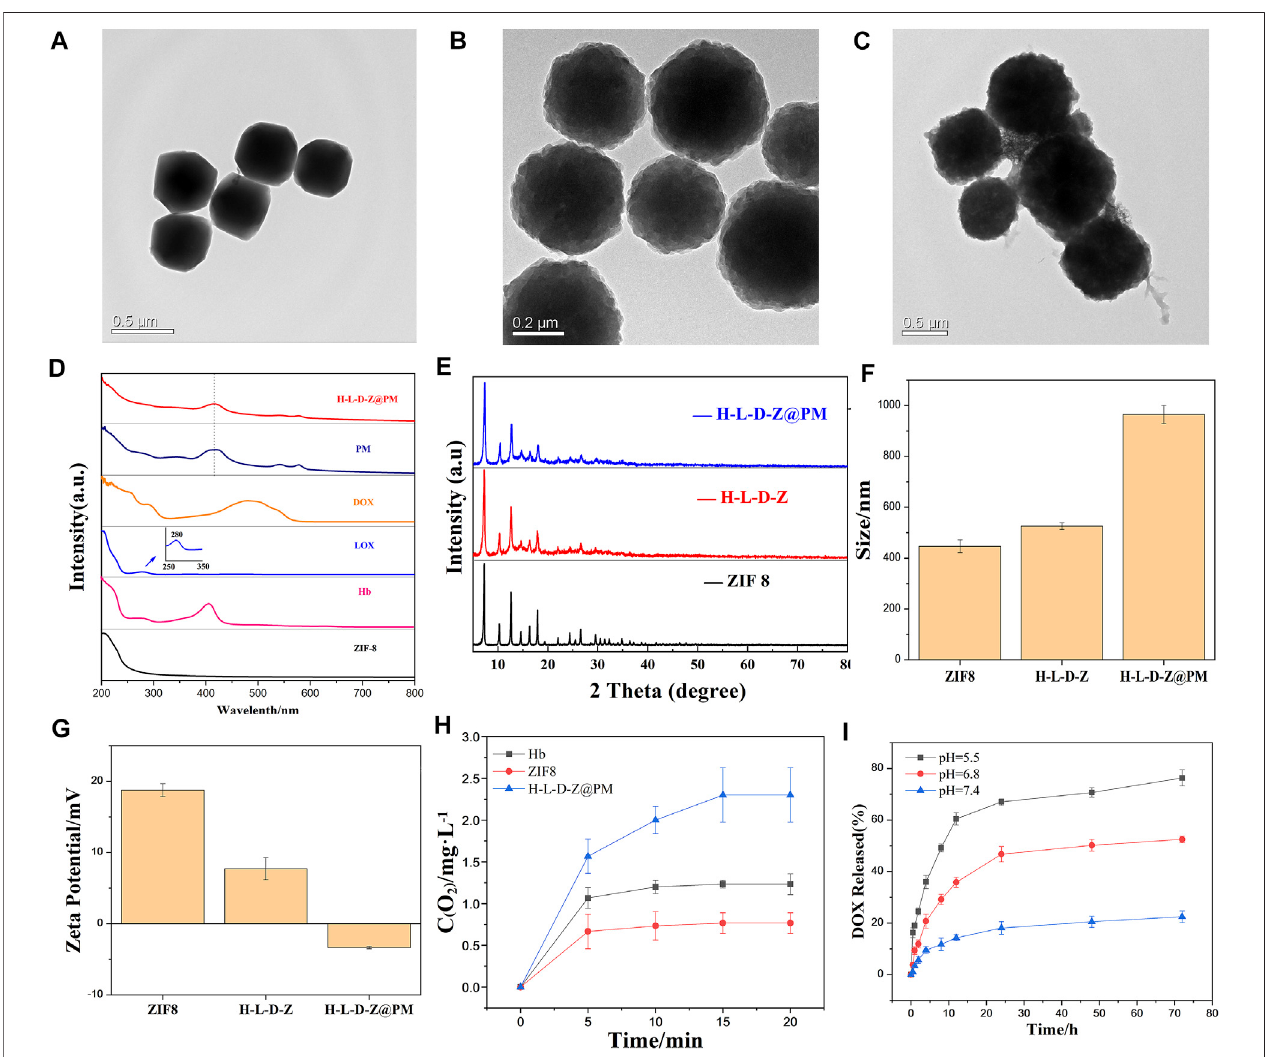
FIGURE 2 | TEM image of (A) ZIF8 NPs, (B) H-L-D-Z NPs, and (C) H-L-D-Z@PM NPs. (D) UV – vis absorption spectra of ZIF8, Hb, LOX, DOX, PM, and H-L-D-Z@ PM. (E) XRD pattern of ZIF8, H-L-D-Z, and H-L-D-Z@PM. (F) Hydrodynamic size distribution and (G) ζ potentials of ZIF8, H-L-D-Z, and H-L-D-Z@PM. (H) Oxygen- carrying and -releasing ability of ZIF8, H-L-D-Z, and H-L-D-Z@PM. (I) Effect of pH on the release of DOX from